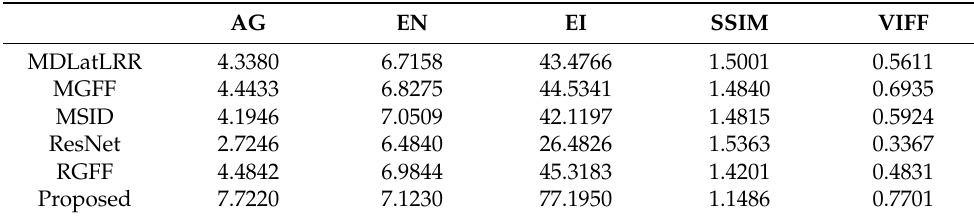
Table 1. Objective analysis for different methods.